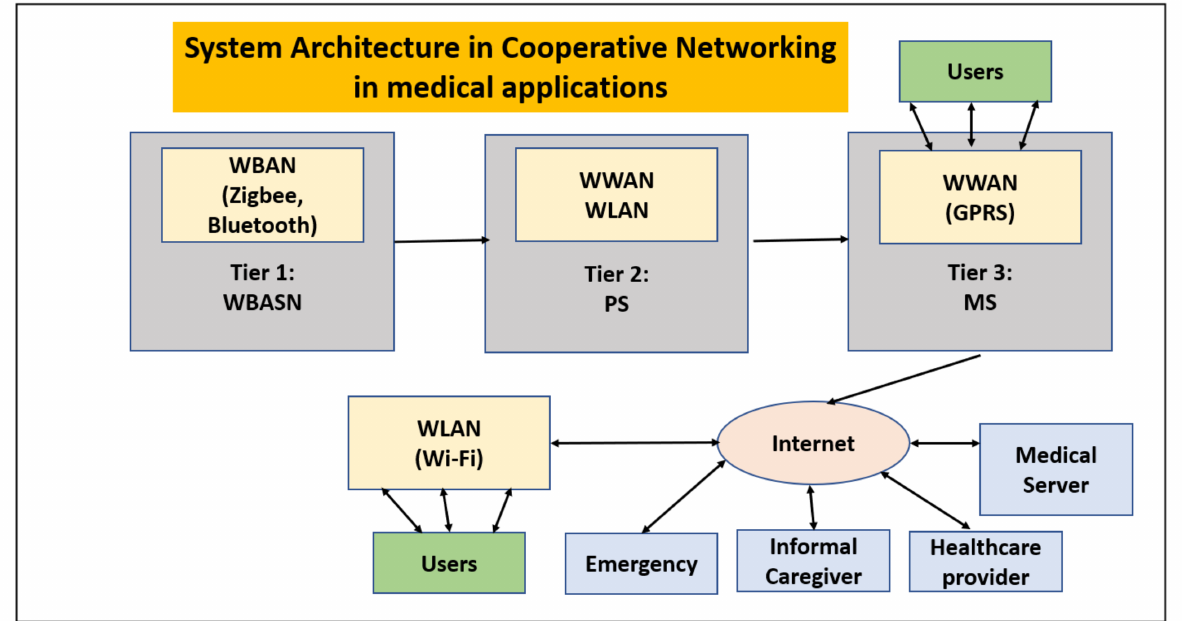
Figure 5. System architecture in cooperative networking in medical